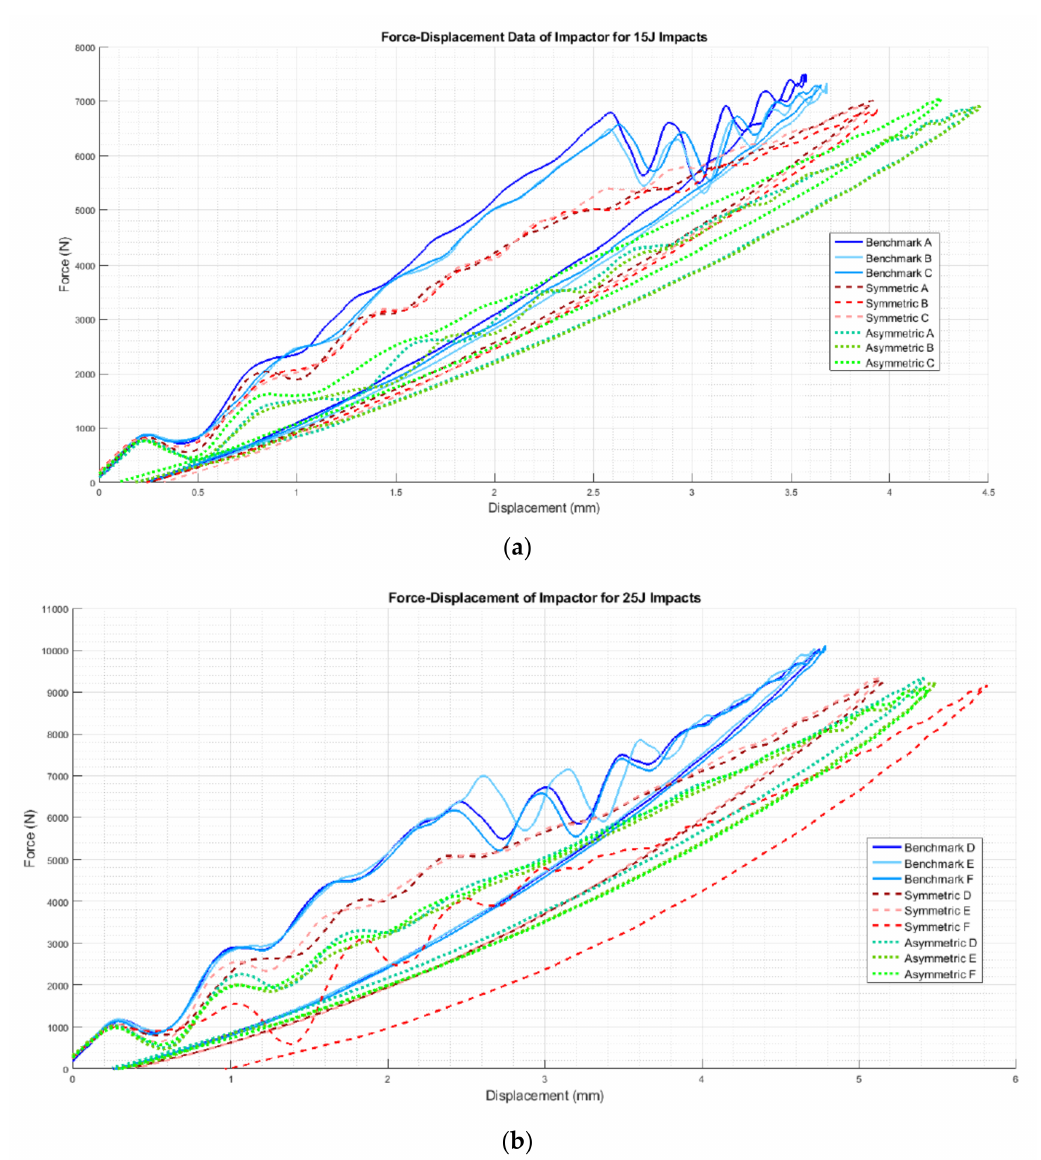
Figure 11. Force–displacement curves for the benchmark, symmetric and asymmetric